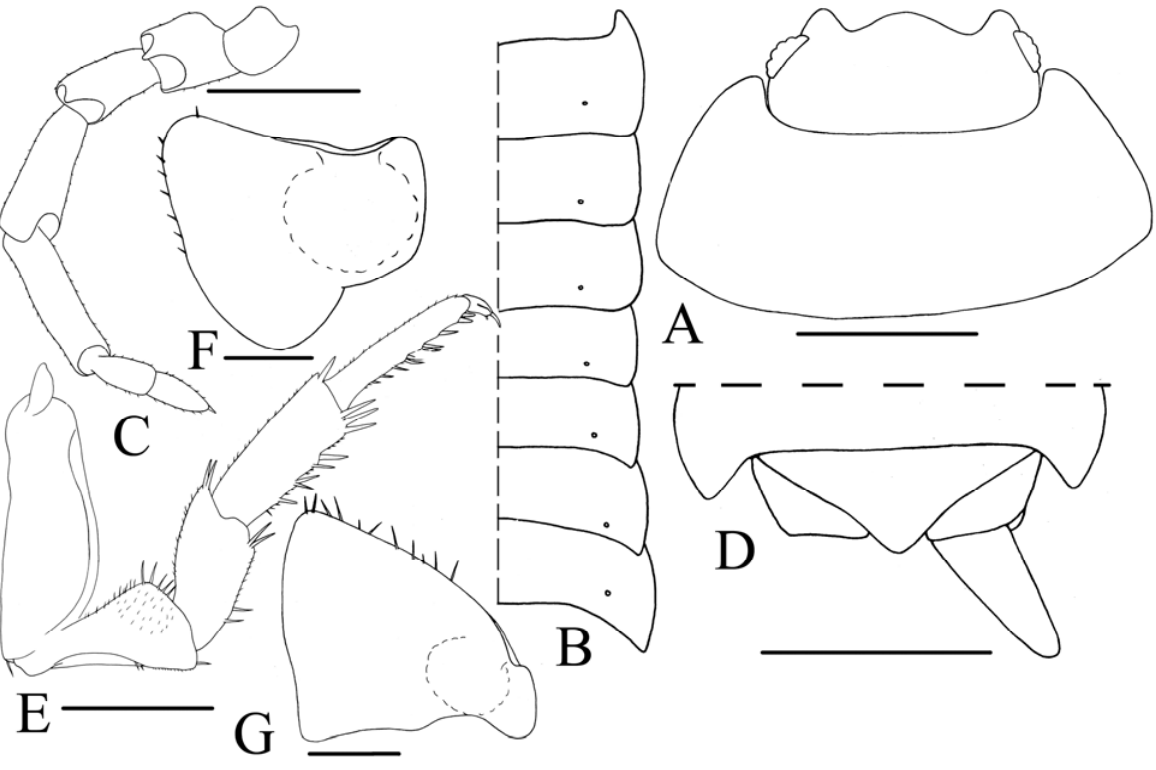
F IGURE 1. Protracheoniscus communis (Borutzky, 1945), holotype. A, cephalon and first pereonite; B, right side of pereon showing disposition of noduli laterals; C, antenna; D, telson and uropods; E, pereopod 7; F, pleopod exopodite I; G, pleopod exopodite V. Scales = 2 mm for A, D; 1 mm for C,